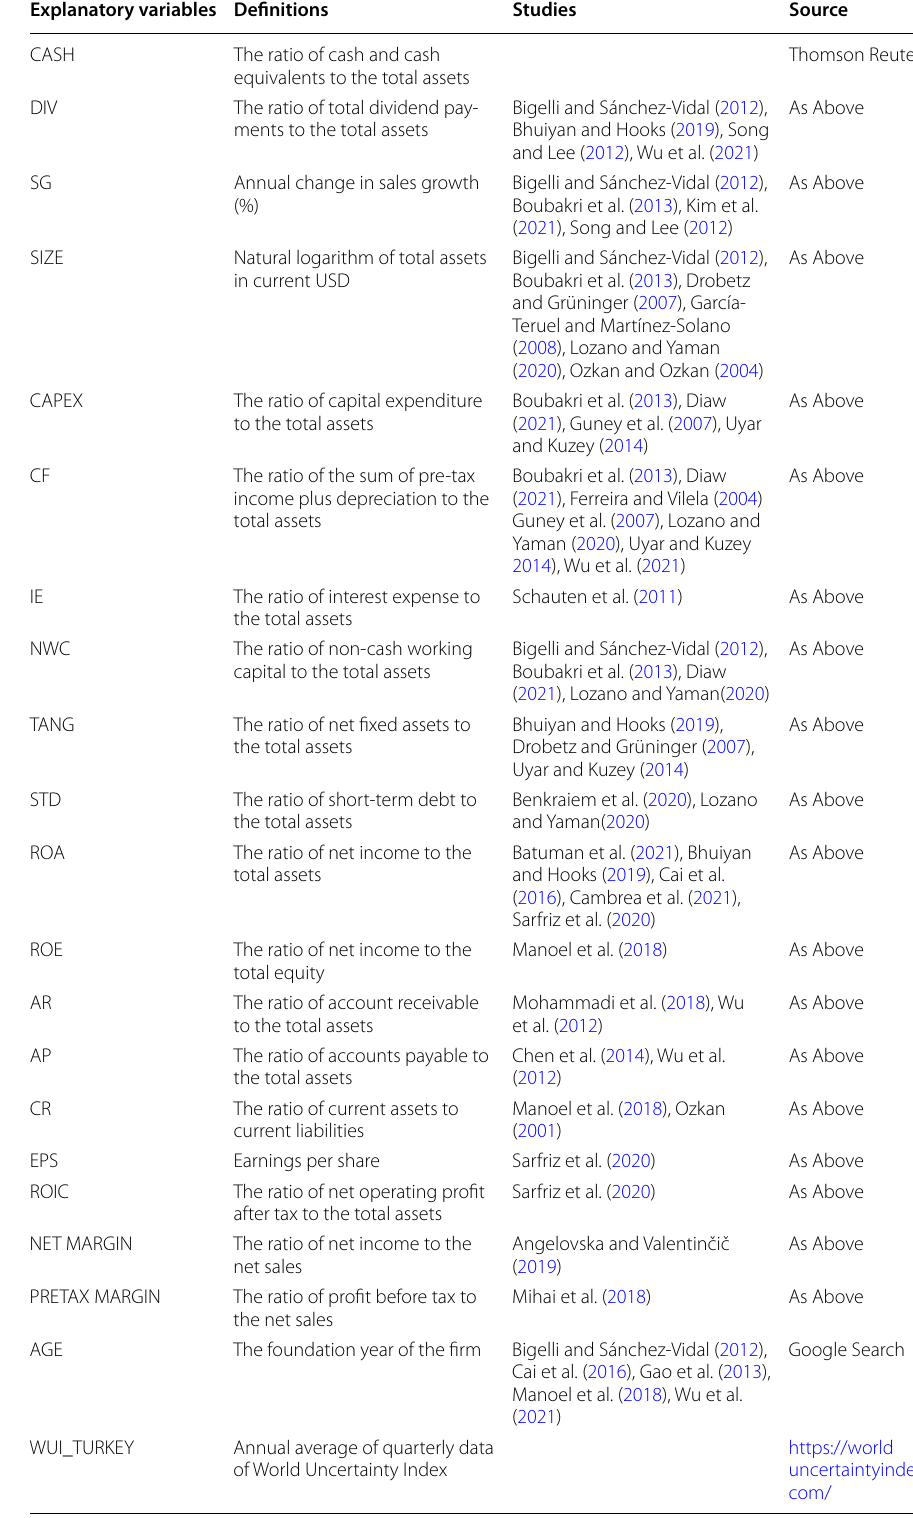
Table 1 Definition of variables and determinants factors of cash